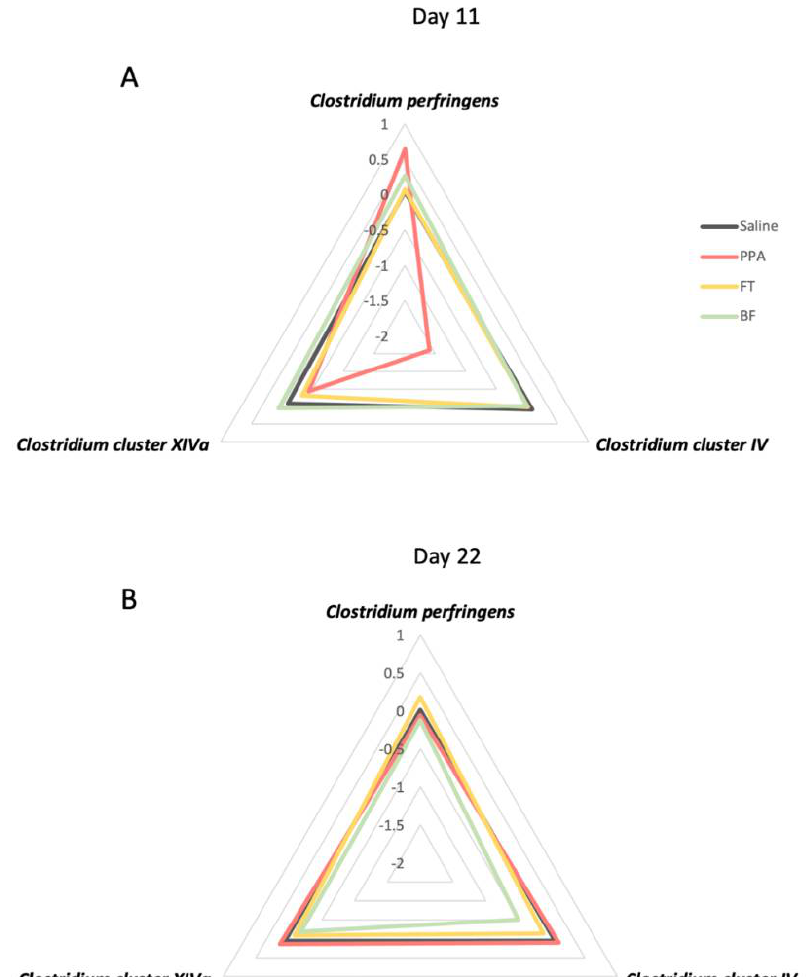
Figure 4. Radar plots of the patterns of fecal Clostridium bacteria levels following propionic acid (PPA) treatment and fecal transplant (FT) and Bifidobacterium (BF) interventions at day 11 and 22 of the intervention: ( A ) levels of Clostridium perfringens, Clostridium cluster IV, and Clostridium cluster XIVa at 11 days; ( B ) levels of Clostridium perfringens, Clostridium cluster IV, and Clostridium cluster XIVa at 22 days. Data presented as log-transformed means of 2 − ∆∆ Ct values.